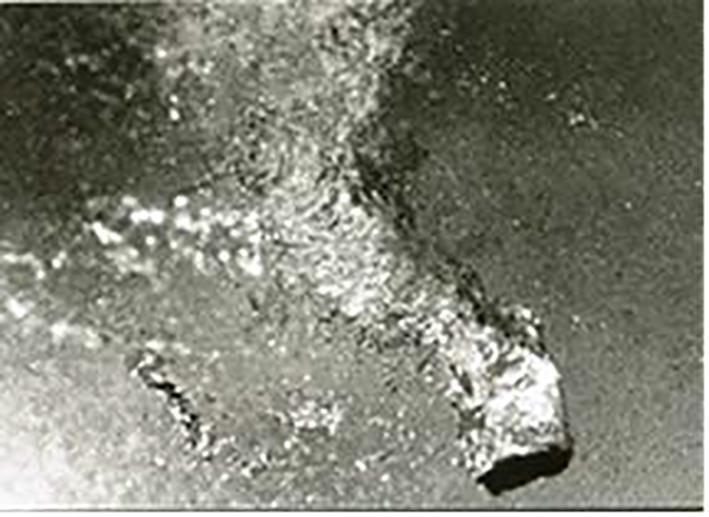
Typical vortex cavitation [3]